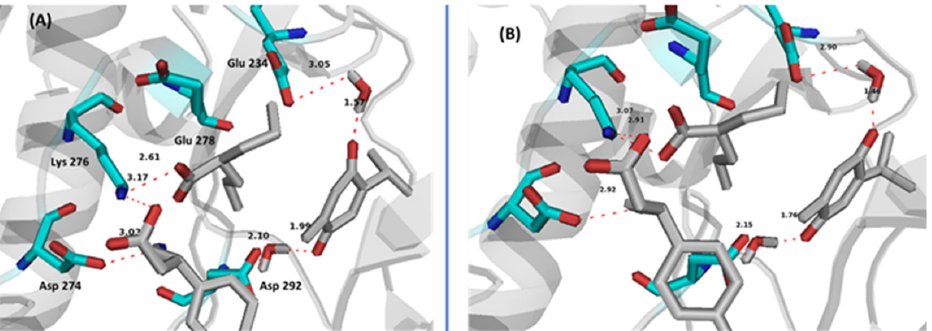
Figure 11. Binding interactions of co ‐ bound ternary supramolecular complex of SVP, BFN and THQ with Akt allosteric site and active site and showing key solvating water molecules. ( A ) first frame in dynamics, ( B ) last frame in dynamics. Distances are represented by red dotted lines and are measured in Angstrom.